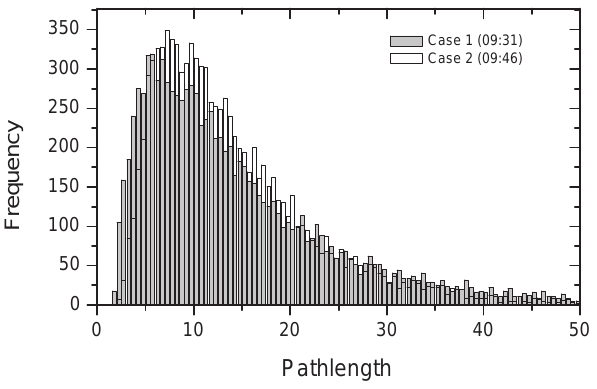
Fig. 6. Monte Carlo path length histograms calculated for the two measurements given in Fig. 5, using the cloud optical thicknesses from Table 3. The distributions show the same qualitative behavior as observed. The distribution is broader for the case of separated layers (1) compare to the case of one compact layer (2).